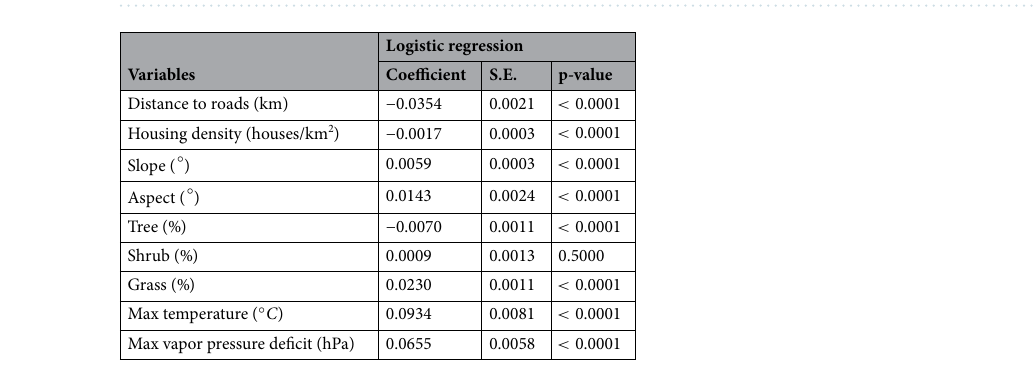
Table 5. Logistic regression results of uncorrelated explanatory variables for California wildfires occurrence (2000–2019).